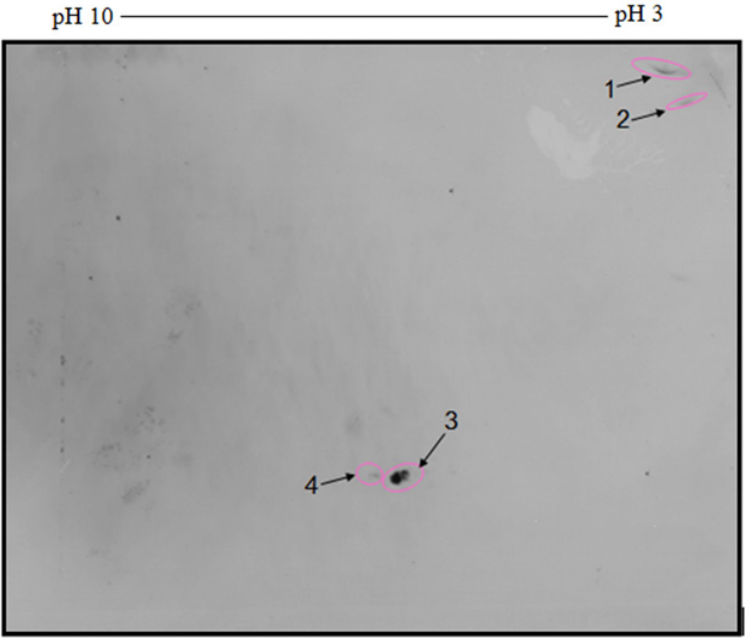
Fig 4. 2D-immunoblotting of T . gondii strain RH tachyzoite proteins probed with goat anti-chicken IgG (H+L chain specific) antibodies conjugated with horseradish peroxidase (secondary antibody) revealed the appearance of immunoreactive polypeptide spots.